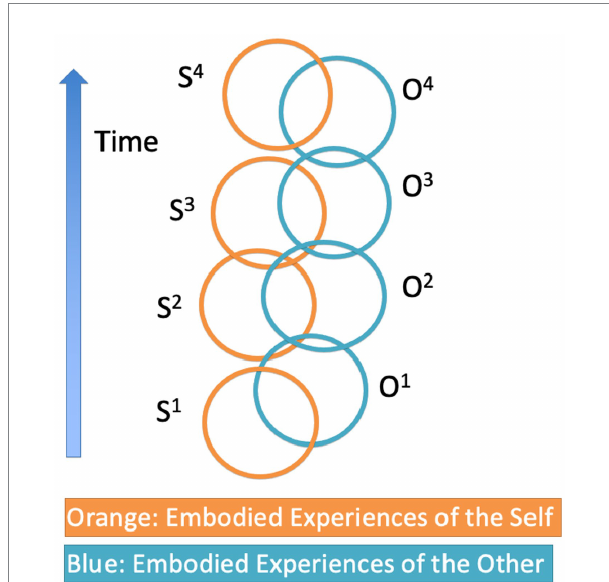
FIGURE 3 Association by similarity in the formation of shared mental states [adapted from Figure 2 in Vincini et al. (2017)]. The orange circles represent the experiences of an individual that present themselves as pertaining to her embodied self. The blue circles represent the experiences that present themselves to the same individual, but this time as belonging to a different embodied subject. Each experience of the self has a significant overlap with a corresponding experience of the other. The features that the experiences have in common can be morpho-kinetic features of the expressive behaviors of self and other, vocalizations, having the same goal, and other kinds of features that should be investigated in detail beyond the usual assumption that similarities play a role in the formation of shared intentionality. Because of their similarity or overlap, the experiences of self and other tend to be experienced as part of a unitary experiential whole. Furthermore, since in social interaction the experiences of self and other have temporal links (e.g., contiguity), they configure shared states or experiences as unitary temporally extended events